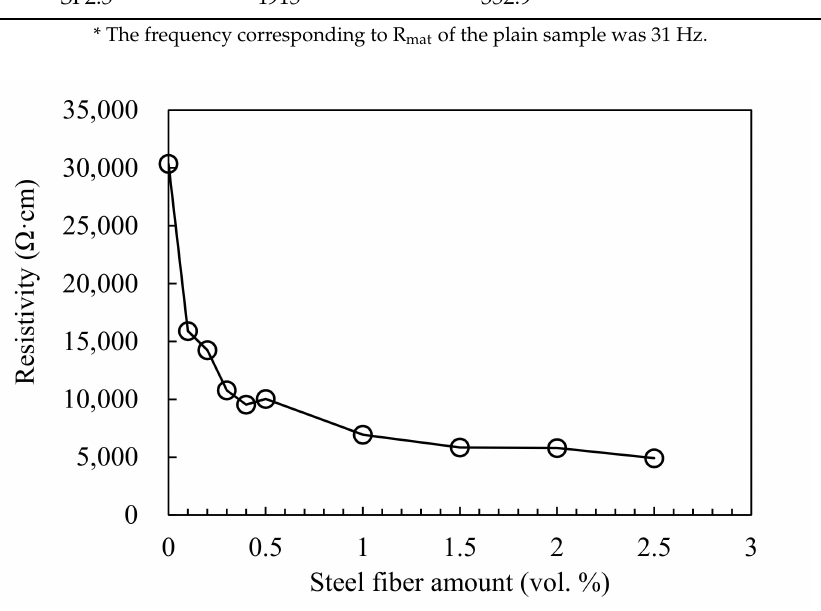
Figure 4. Resistivity of 100 MPa HPFRCC as a function of steel